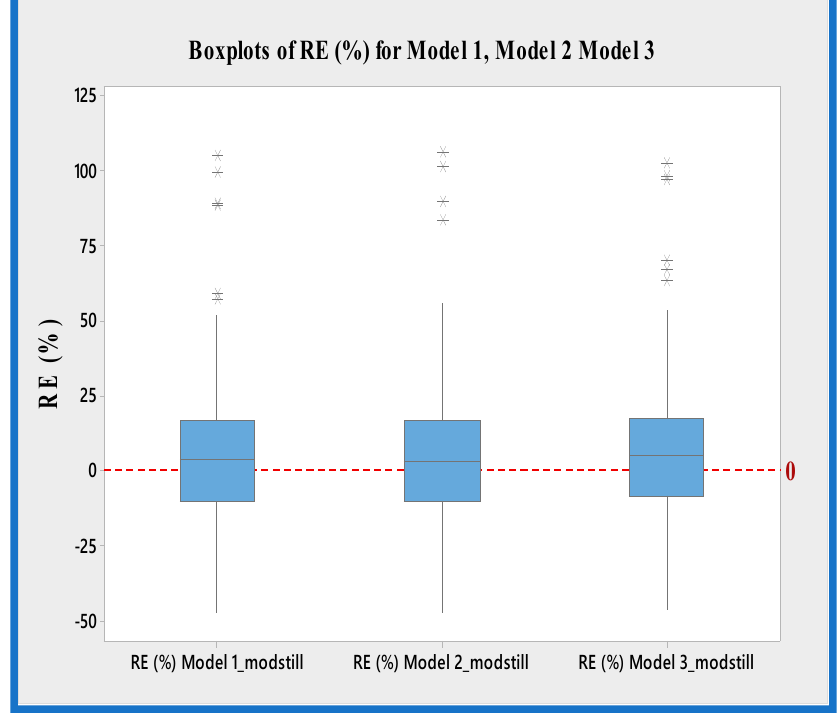
Figure 7. Relative error RE (%) of Models 1, 2, and 3 (mod-still). (* represents outlier data).